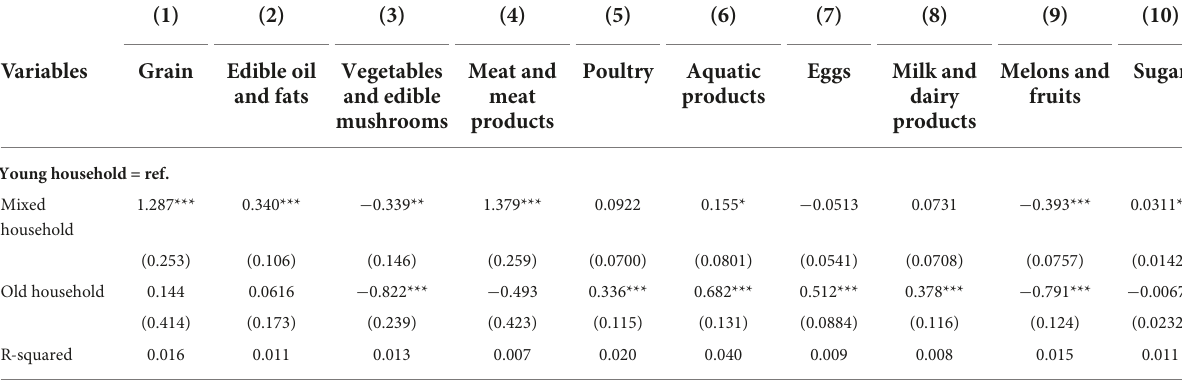
Young household =